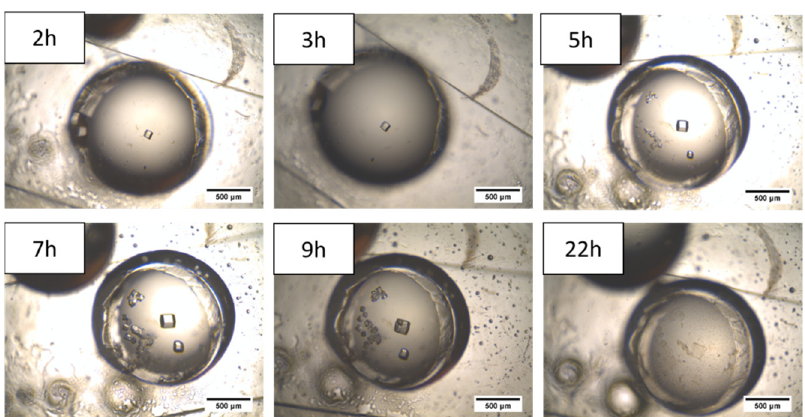
Figure 9. HEWL crystals evolution in the well-type micro-contactor when using the protonated 117 Nafion ® membrane.